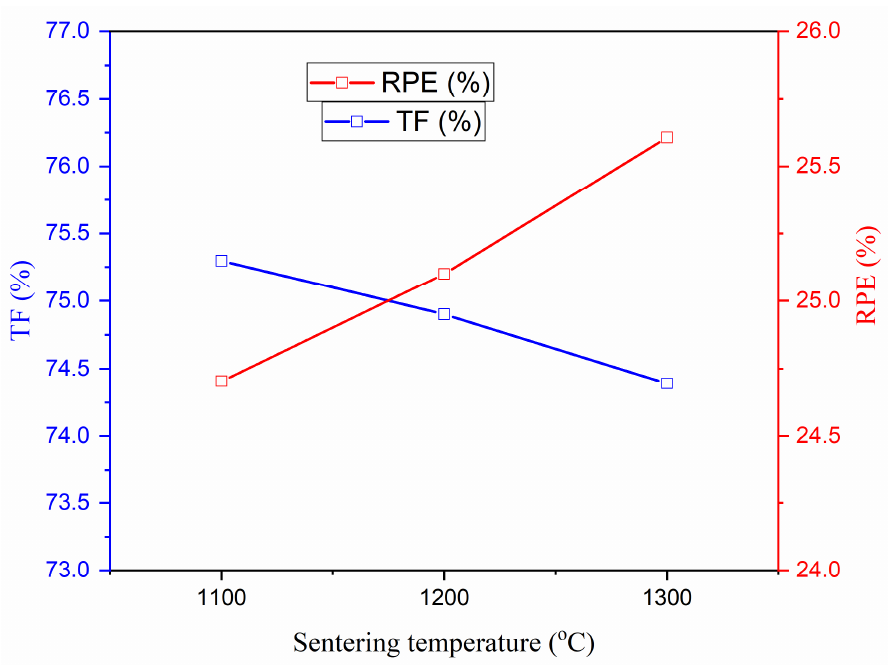
Figure 9. Variation of both TF and RPE versus the sintering temperature.